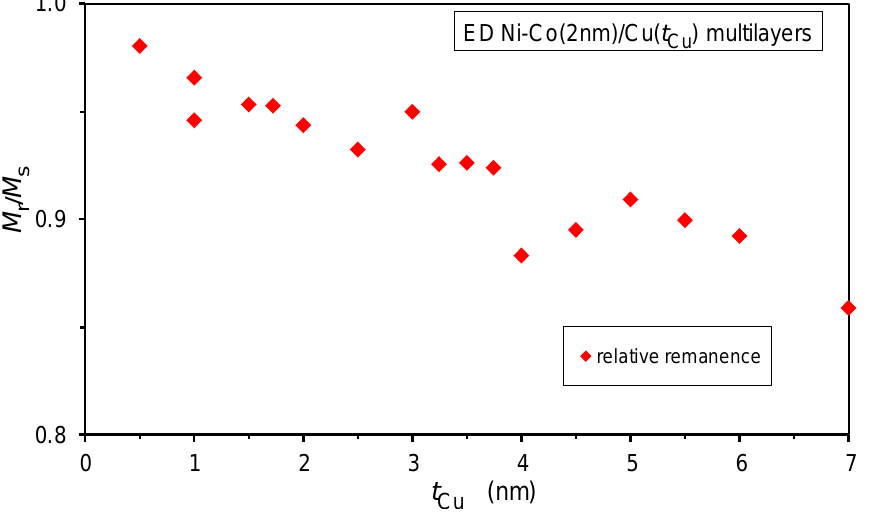
Figure 10. Relative remanence M r / M s vs. non-magnetic layer thickness t Cu for the present Ni 65 Co 35 /Cu multilayers as obtained from the magnetic hysteresis loops.